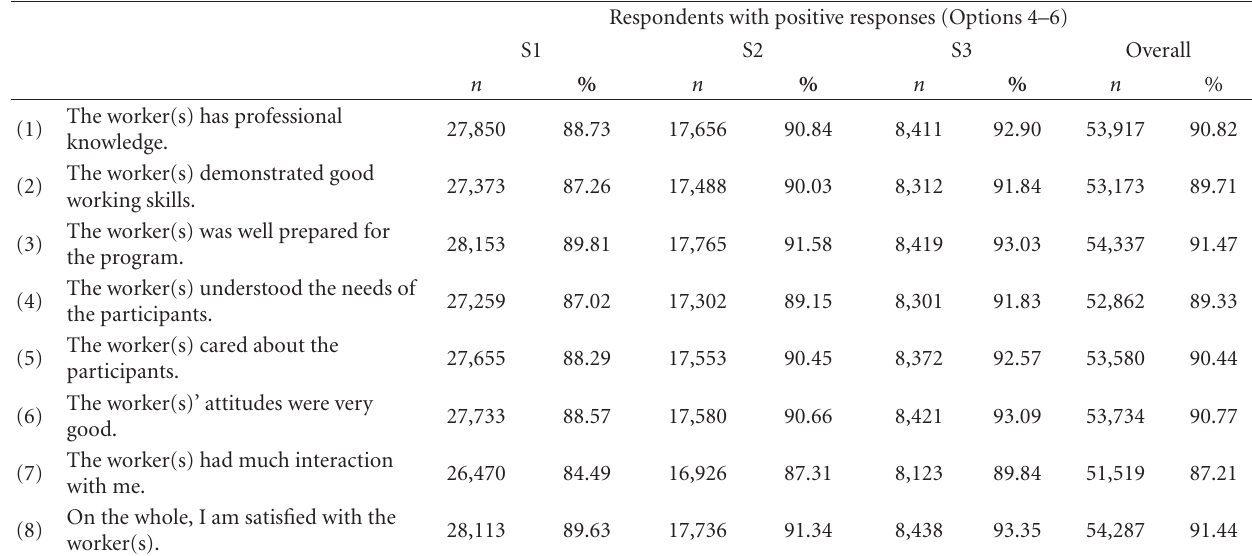
Table 4: Summary of the students’ perception towards the worker(s).